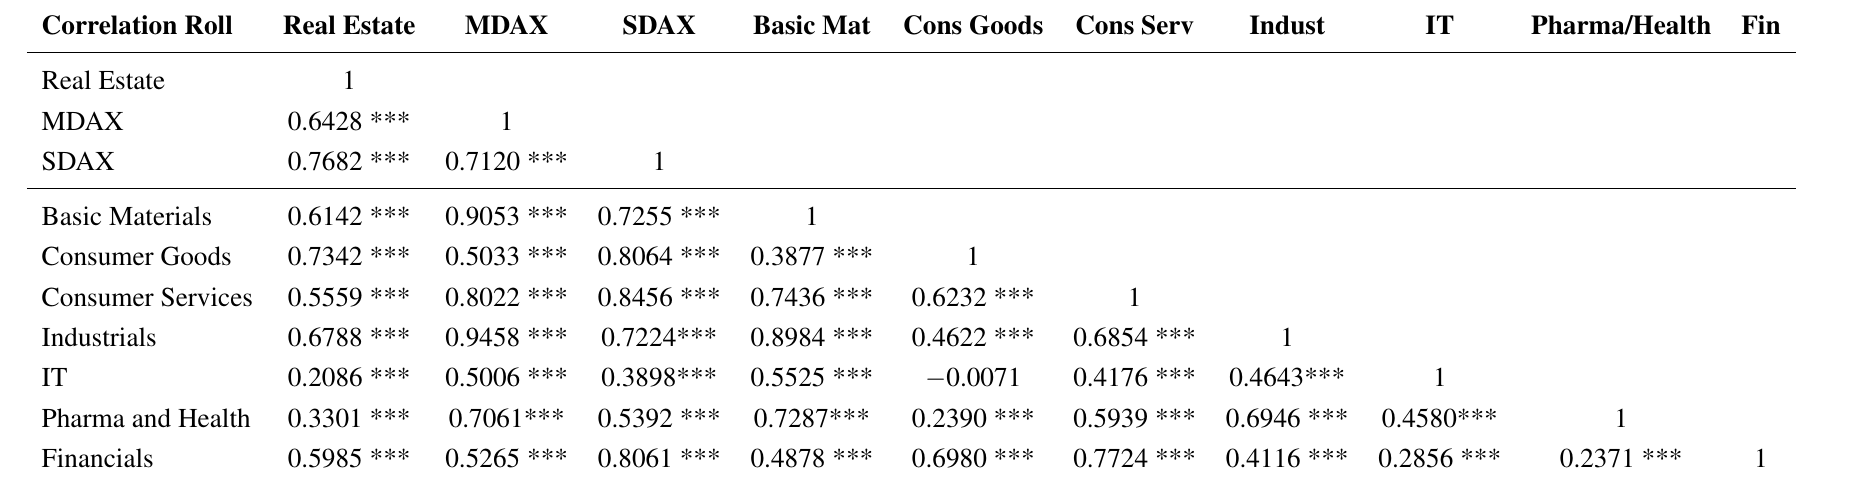
Table A4. Amihud illiquidity correlations between several asset